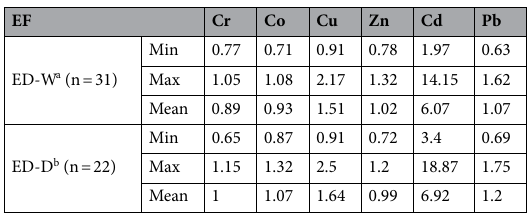
Table 2. The EF values of six heavy metals in sediments from the East Dongting Lake in the wet and dry seasons. a East Dongting Lake in the wet season. b East Dongting Lake in the dry season.